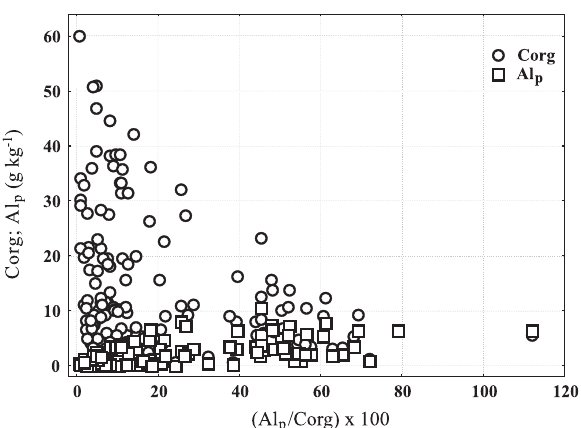
/Corg) x 100 e o conteú- p